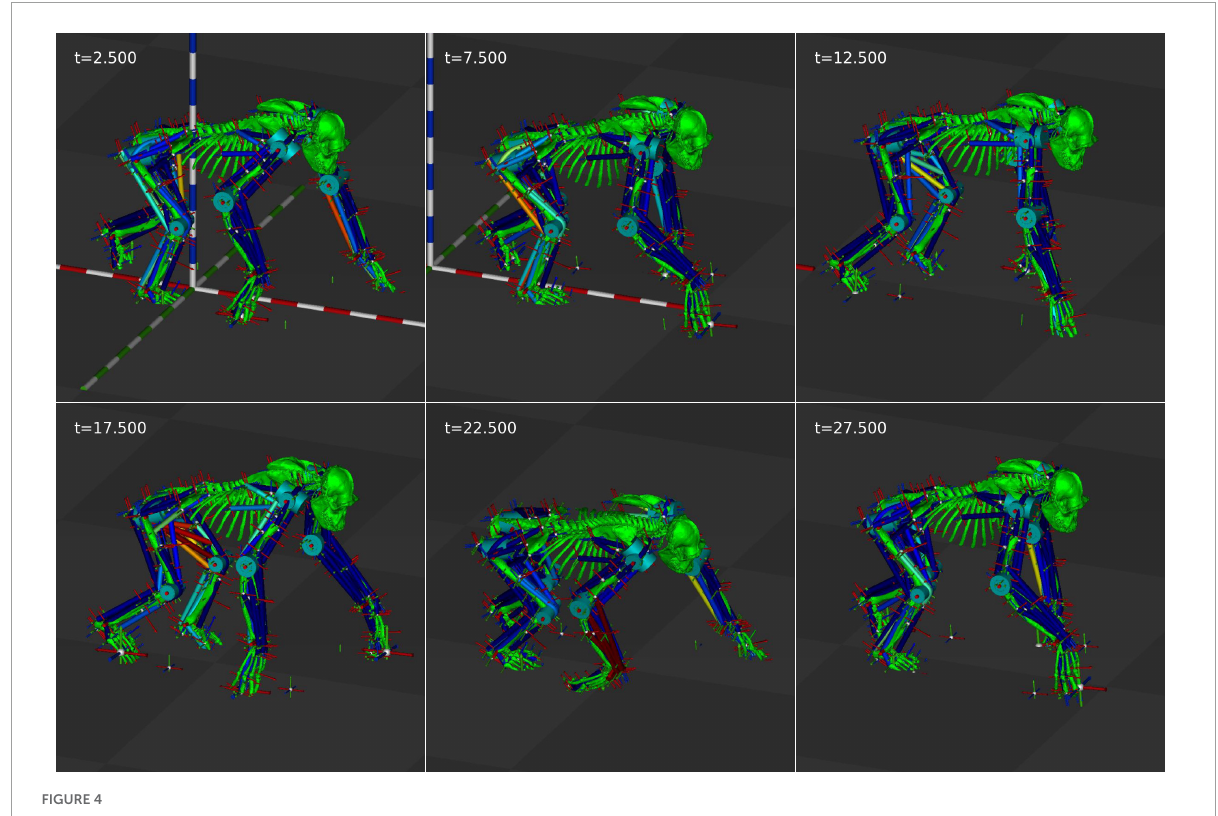
FIGURE4 Still frames from the start-stop animation at 5 s